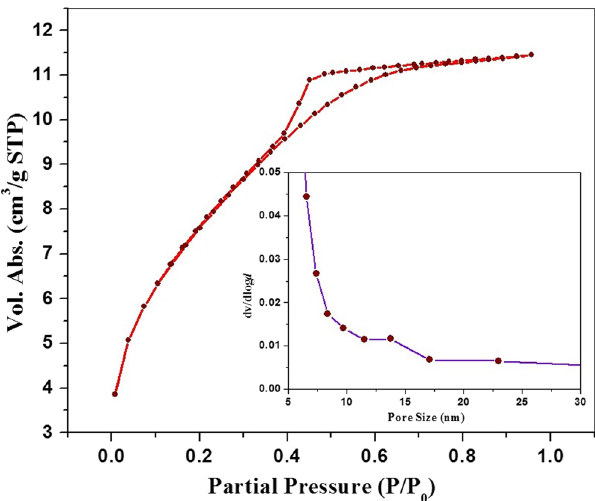
Figure 4. BET analysis of